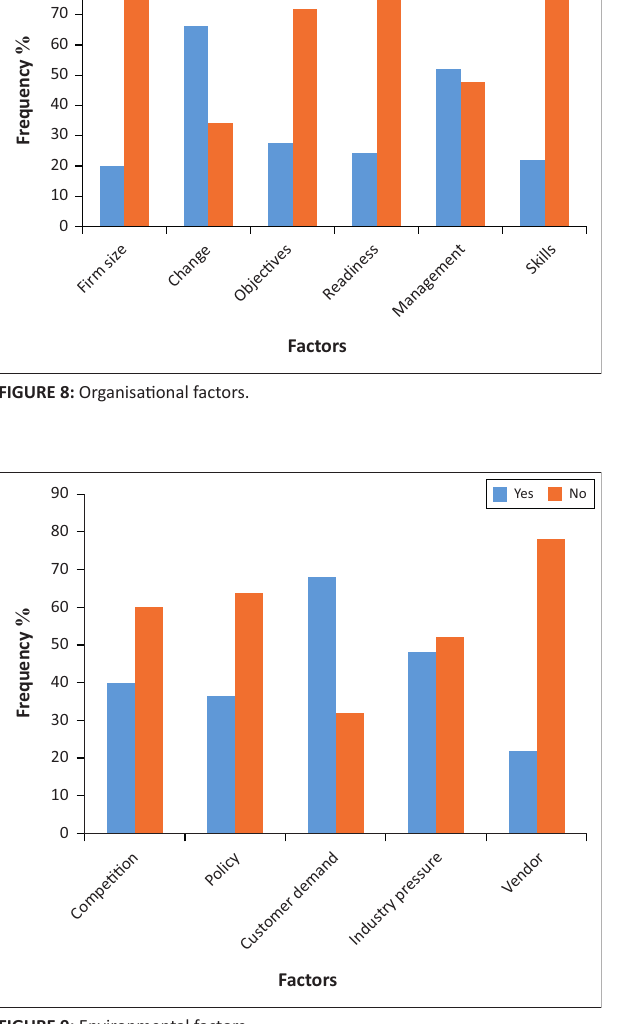
FIGURE 9: Environmental factors.